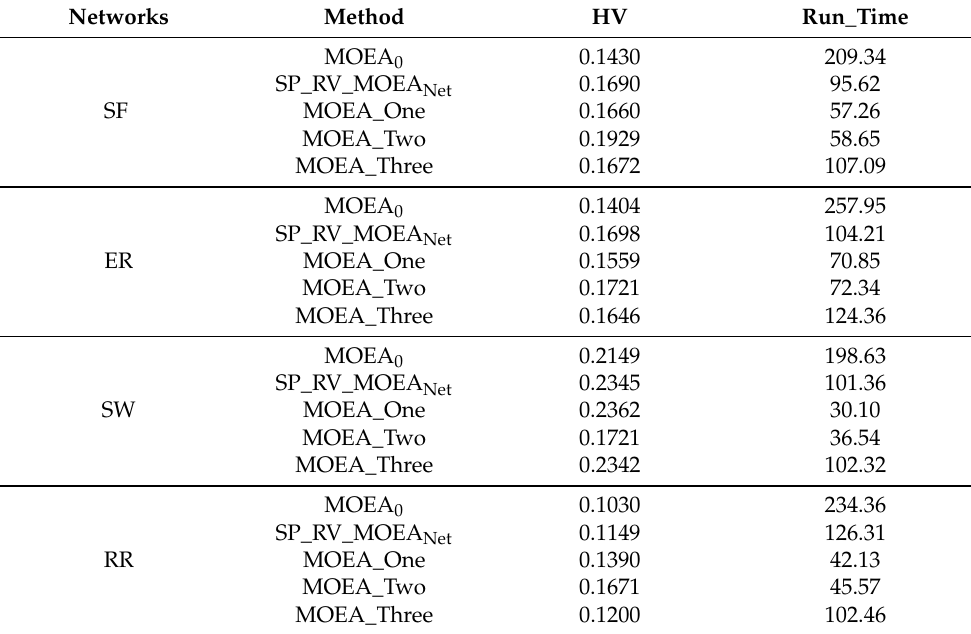
Table 5. Running time (hours) and HV values of the four types of network with different methods.